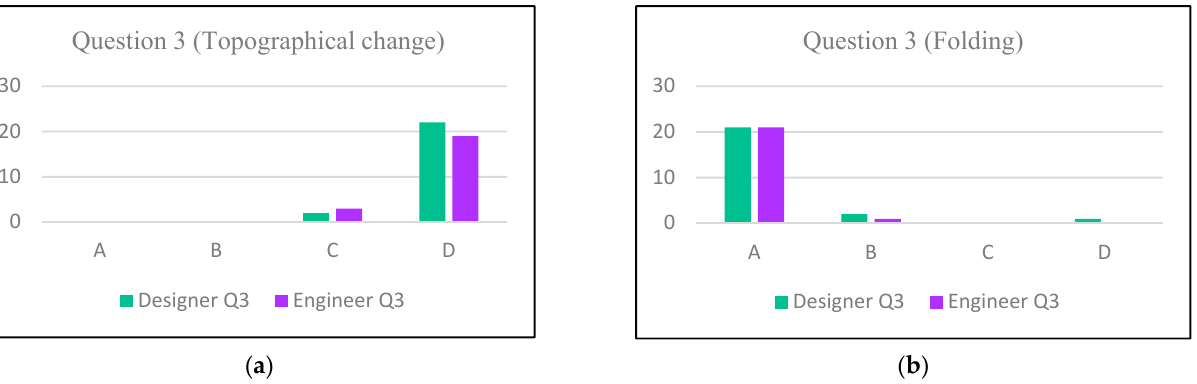
Figure 9. ( a ). Results from (Insertion task-Question3—Topographical change) ( b ). Results from (In-